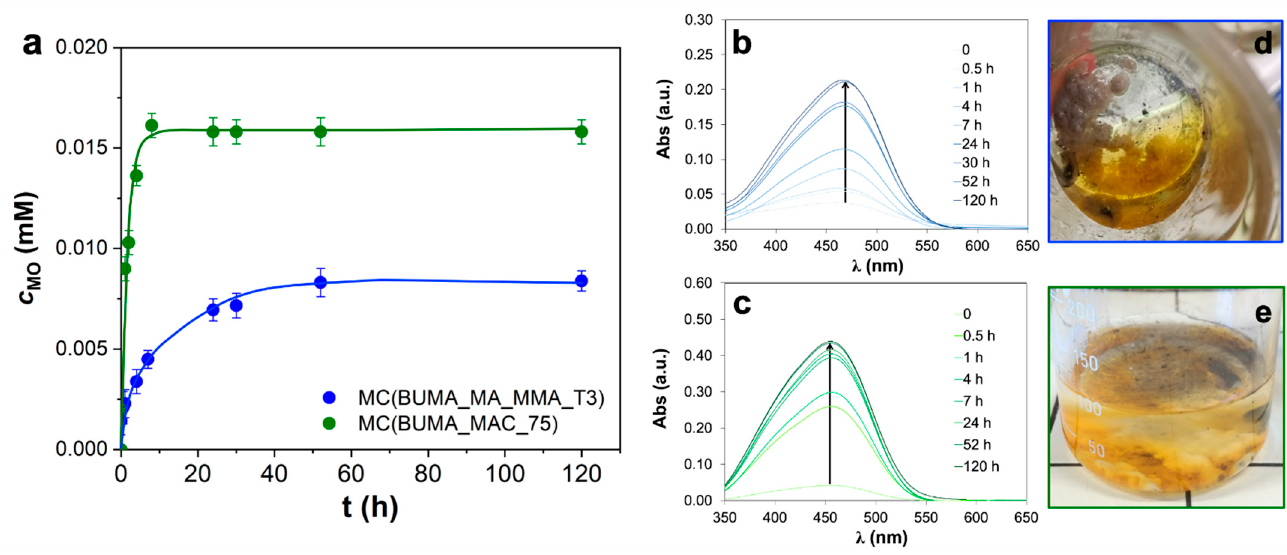
Figure 4. ( a ) Released MO concentration curves relative to MC(BUMA_MA_MMA_T3) and MC(BUMA_MAC_75) systems. Error bars computed on three different replicates. ( b , c ) Corresponding kinetics followed through ultraviolet/visible (UV/Vis) analysis, along with the relative ( d , e ) photos taken at the end of the test (120 h).